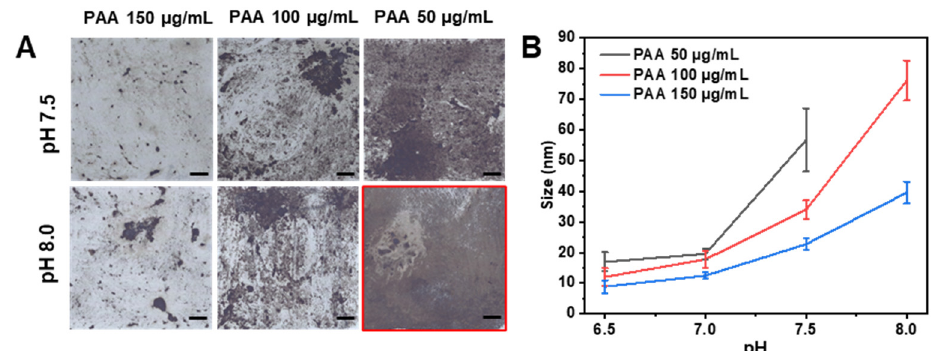
Figure 7. Collagen films in different conditions of growth solution. ( A ) Collagen films with HAP nanocrystals in different conditions of the solution, and the species of extrafibrillar growth of HAP is marked with red dox (scale bar, 2 mm). ( B ) Sizes of precursors in different conditions when the solution is in the condition of PAA 50 µ g/mL, pH 8.0. The precipitate of HAP will form rapidly and size data cannot be obtained.